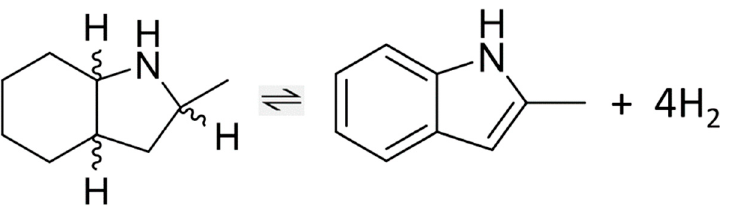
Figure 9. Dehydrogenation of 2-methyl-H8-indole to 2-methyl-indole (reaction R-IV) to release 4 moles of hydrogen.